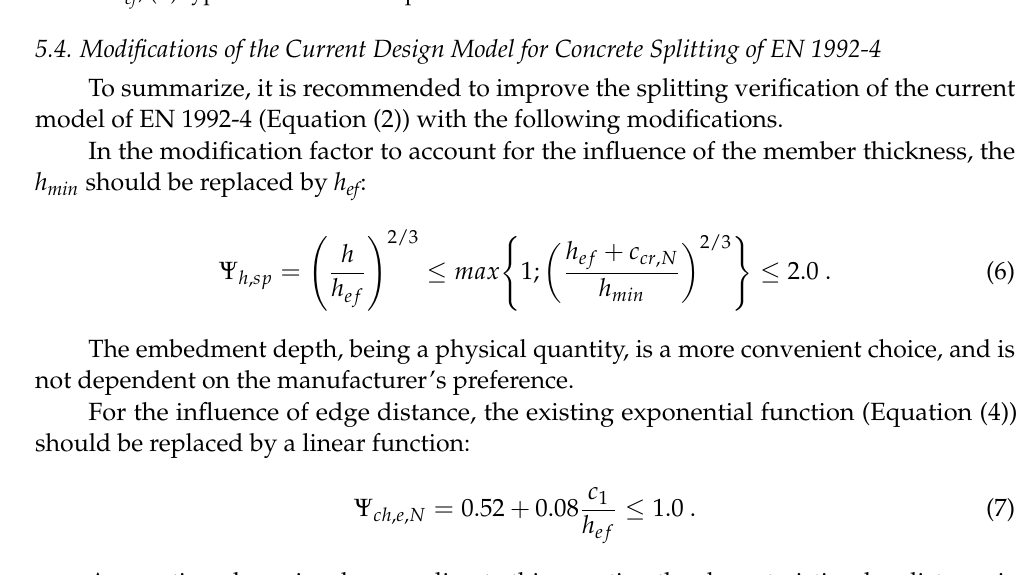
Figure 8. Influence of anchor spacing-numerical results compared to the current code provisions for: ( a ) shallow embedment depth— s cr,N is calculated for actual h ef ; ( b ) typical embedment